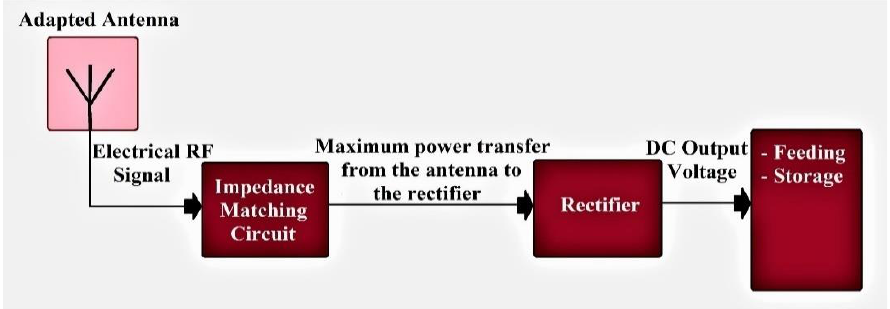
Figure 1. RF Energy Harvesting system blocks.